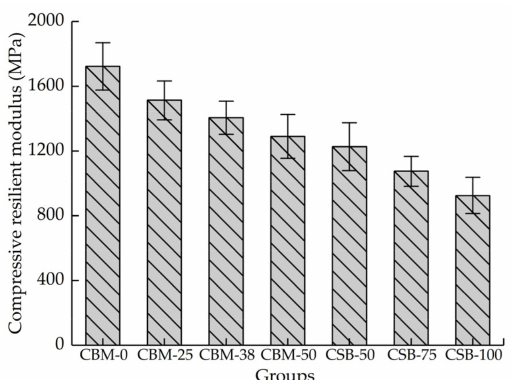
Figure 11. The compressive resilient modulus of mixture with 5% cement dosage after curing for 90